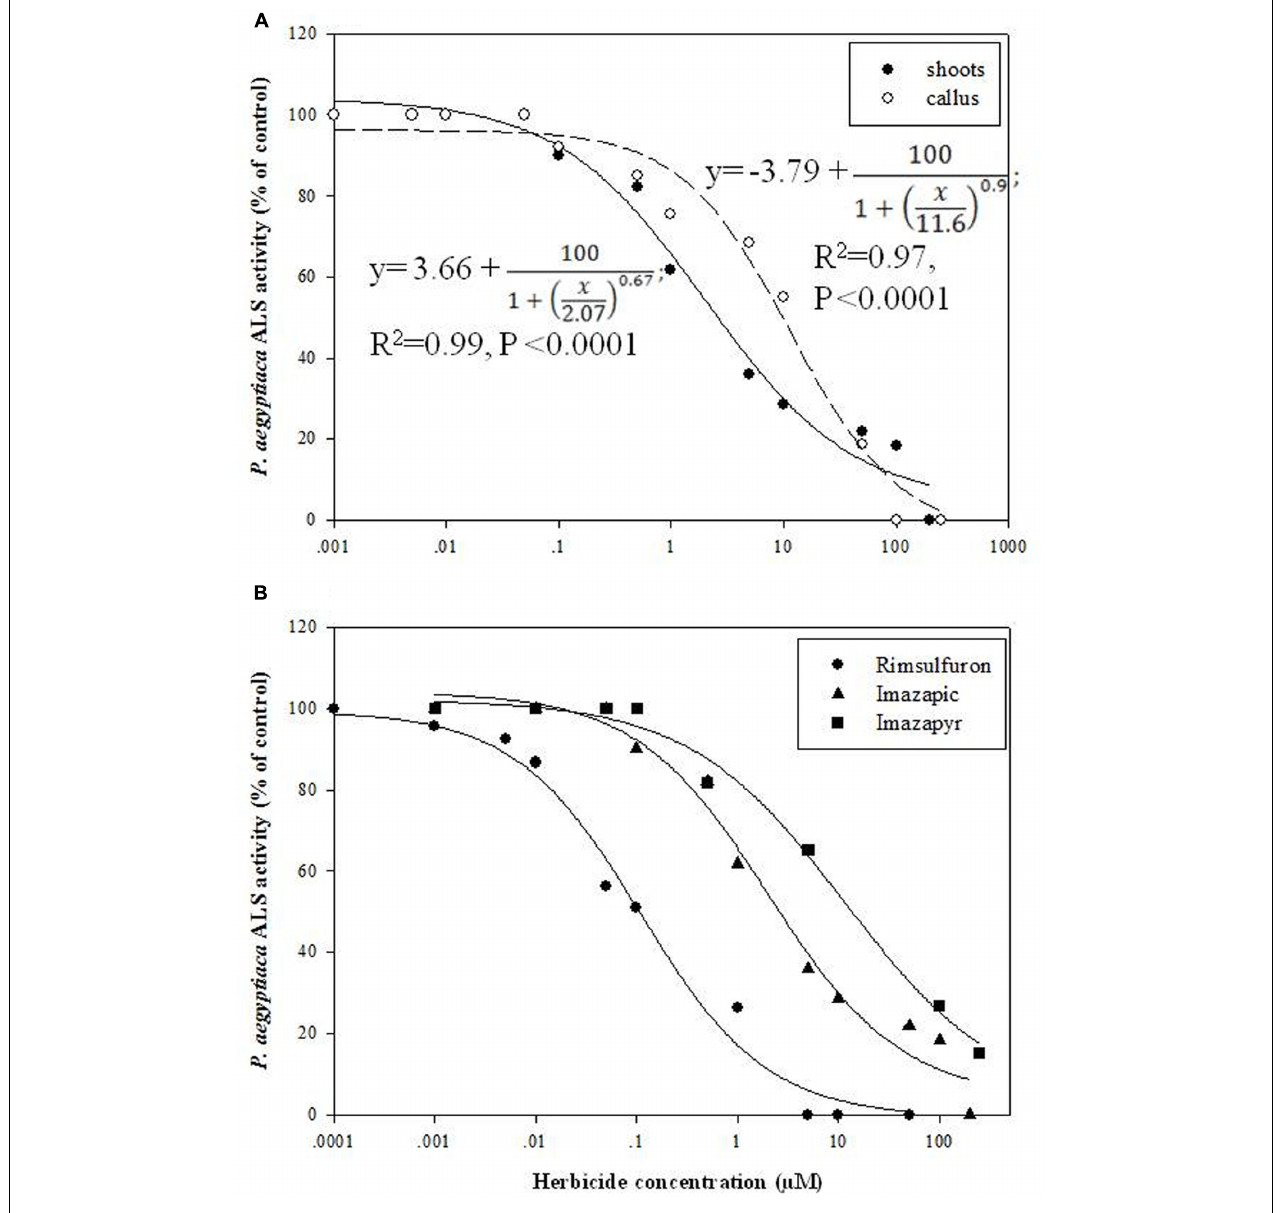
FIGURE 5 | Influence of ALS inhibitors on ALS activity of P. aegyptiaca. (A) Influence of imazapic on ALS extracted from flowering shoots and callus. (B) Influence of imazapic, imazapyr, and rimsulfuron on ALS extracted from P. aegyptiaca flowering shoots. The experiment was conducted with four replicates per treatment. The data were computed by non-linear regressions using Sigma-Plot version 11.01. y = y 0 + a a = 100, b = 0.67, x 0 = 2.07, y 0 = 3.66; for callus: R 2 = 0.97, P < 0.0001, a = 100, b = 0.90, x 0 = 11.6, y 0 = − 3.79. (B) For imazapic: R 2 = 0.99, P < 0.0001, a = 100, b = 0.67, x 0 = 2.07, y 0 = 3.66; for imazapyr: R 2 = 0.99, P = 0.0073, a = 100, b = 0.56, x 0 = 11.62, y 0 = 2.18; for rimsulfuron: R 2 =